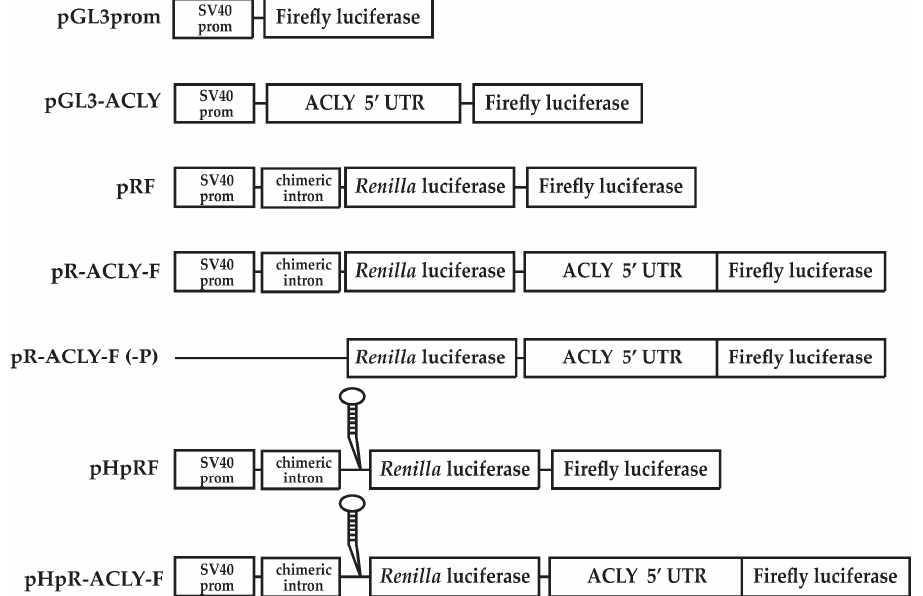
Figure 2. Constructs in pGL3prom, pRF and pHpRF. pGL3-ACLY contains ACLY 5 (cid:48) untranslated region (UTR) inserted into pGL3prom upstream firefly luciferase (FL) cistron. The control dicistronic vector pRF contains the SV40 early promoter (prom), a chimeric intron, and the cDNAs encoding Renilla luciferase (RL) and FL separated by a short linker sequence. pR-ACLY-F construct is obtained by cloning the ACLY 5 (cid:48) UTR between the two cistrons RL and FL. The ACLY 5 (cid:48) UTR was also cloned between the two cistrons RL and FL of pHpRF obtaining the pHpR-ACLY-F construct. The pHpRF di ff ers from pRF because it contains an inverted repeat upstream the first cistron, in order to form a stem–loop at the 5 (cid:48) end of the transcript. pRF(-P) and pR-ACLY-F(-P) constructs are identical to their corresponding pRF constructs described above, except that they do not contain the SV40 early promoter and the chimeric